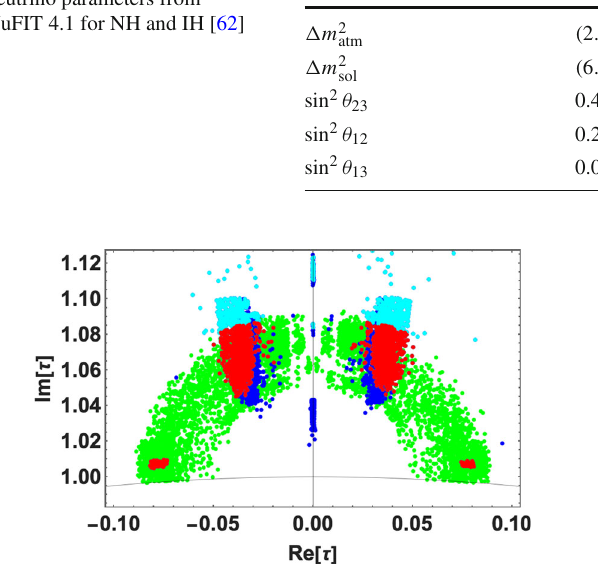
(cid:20) Fig. 6 Allowed region on the m i – δ (cid:4) plane, where the vertical CP solid line is the cosmological bound, for NH . Colors of points corre- spond to points of τ in Fig.